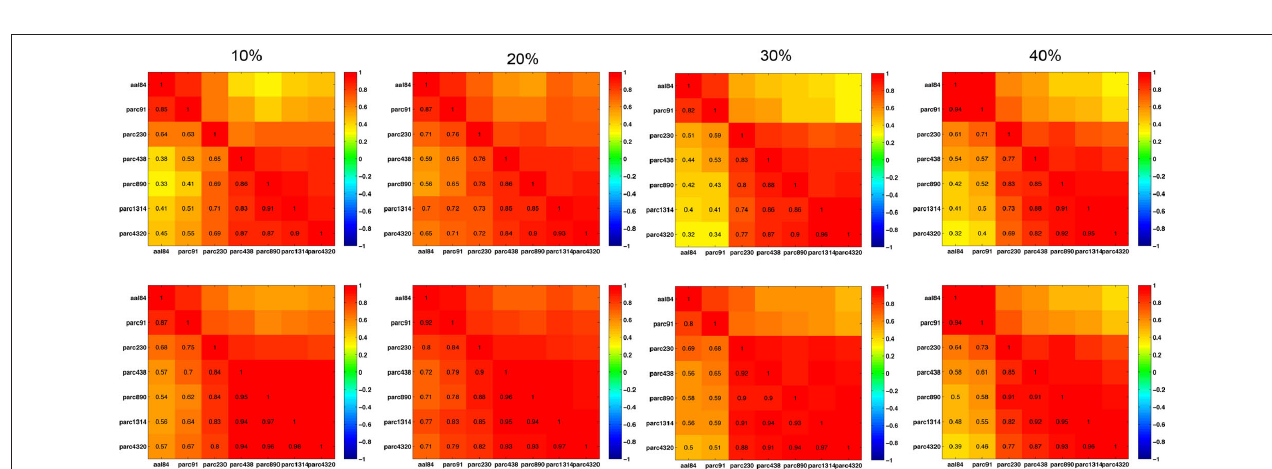
FIguRe 10 | Mean values of the power-law exponent (slope, left) and exponential cutoff (right) of the degree distributions at each parcellation scale for costs of 10, 20, 30 and 40%. * p < 0.05.